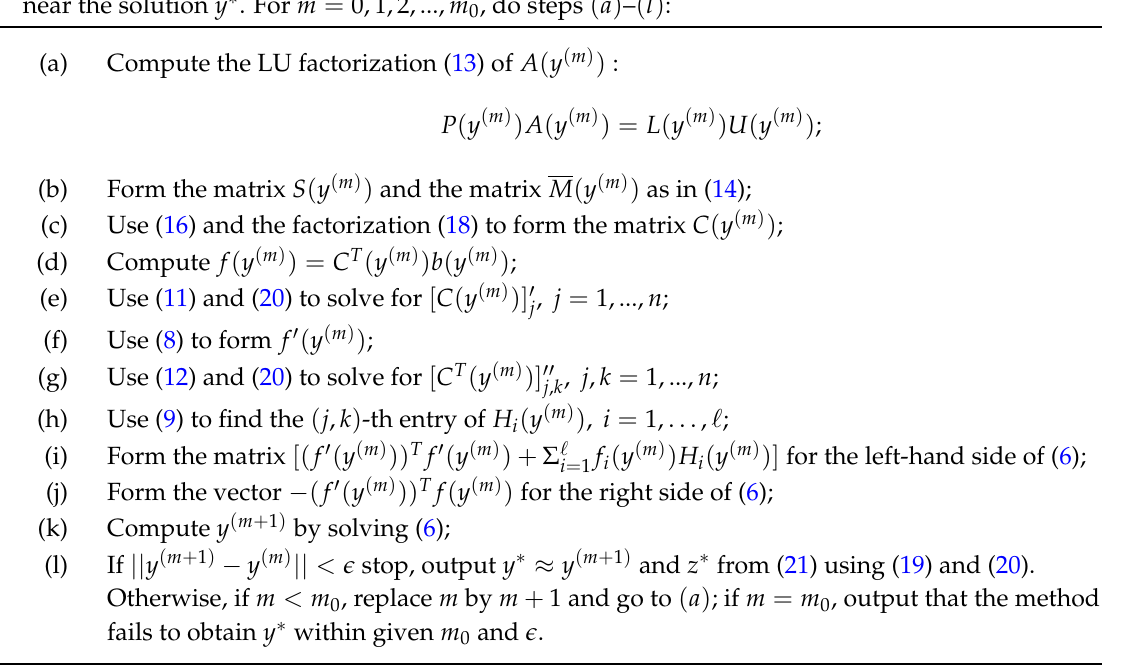
Algorithm 1: Given the function F ( y , z ) = A ( y ) z + b ( y ) with a matrix A ( y ) that is full rank in a neighborhood of y ∗ , a small positive real number (cid:101) , a positive integer m 0 , and a point y ( 0